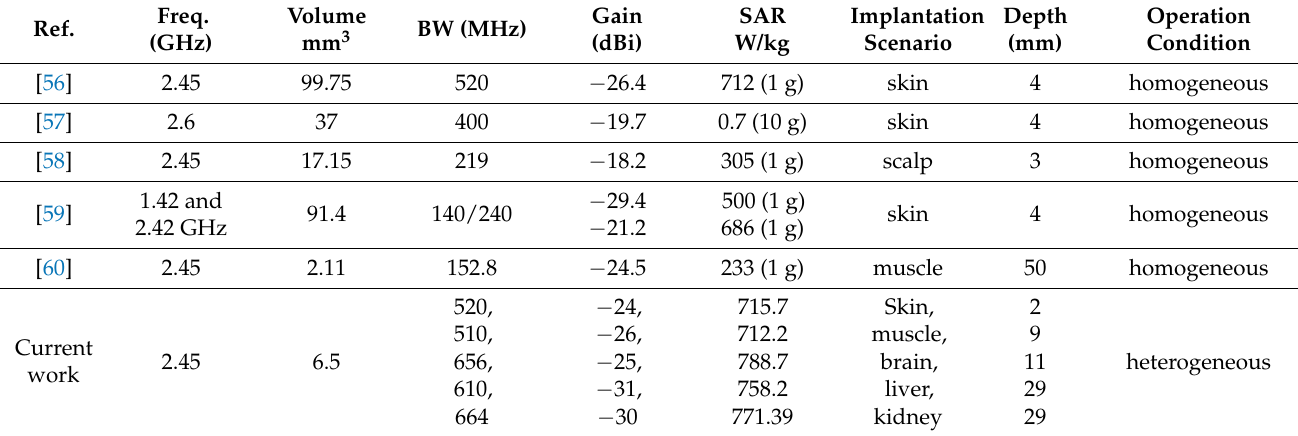
Table 5. Comparison of proposed antenna and similar prior studies in recent